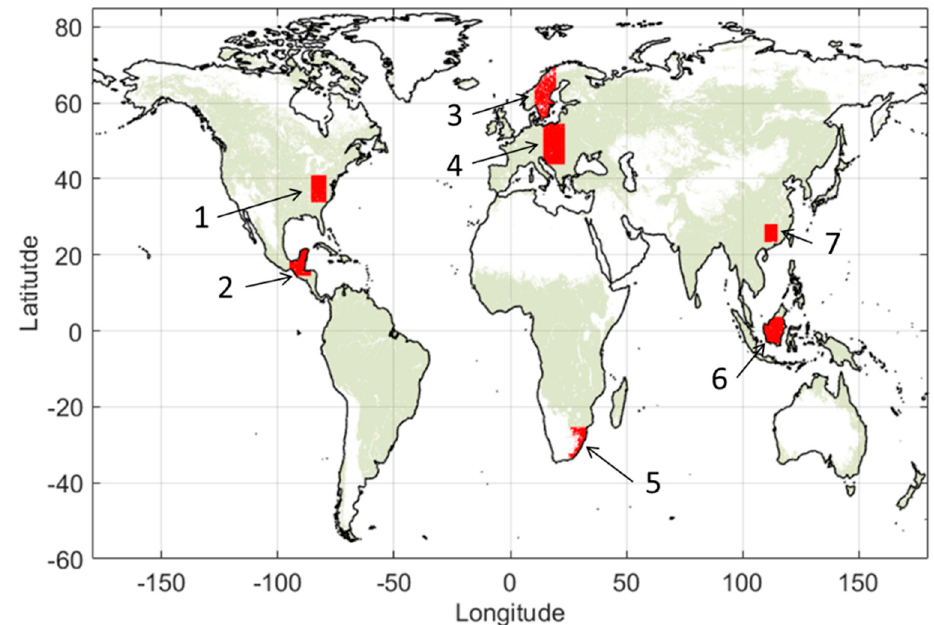
contain robust needleleaf species and coverage by single pine and spruce trees.